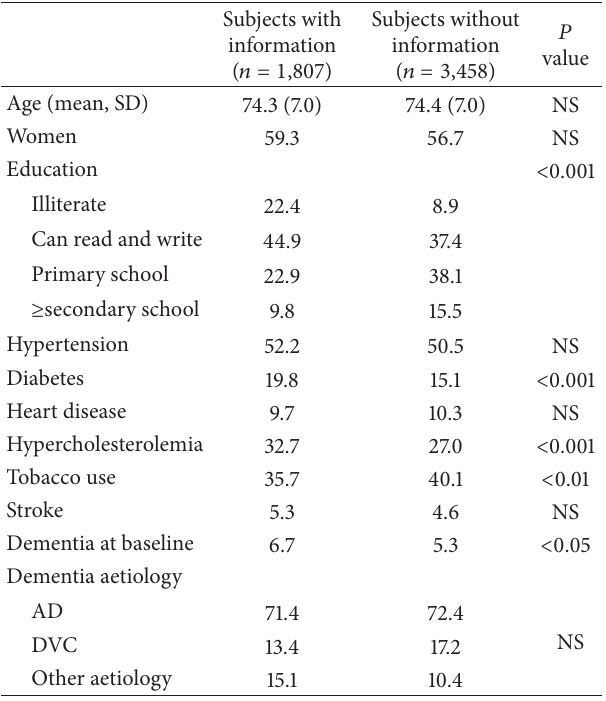
Table 1: Characteristics of subjects with and without complete information on